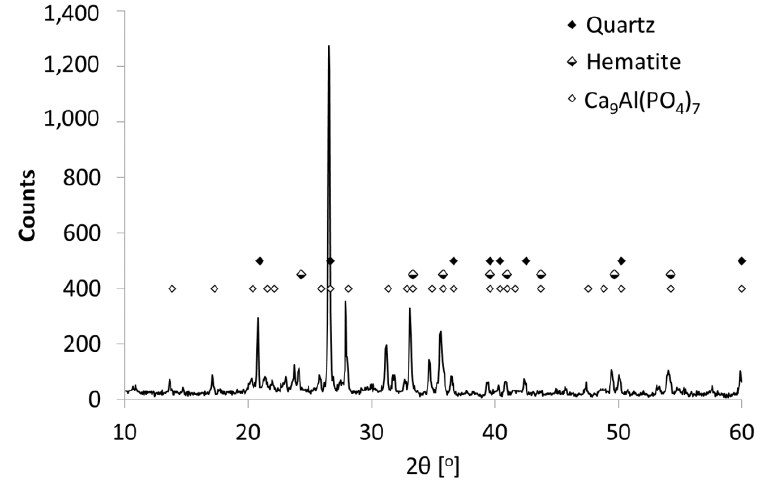
Figure 2. SSA phase composition.